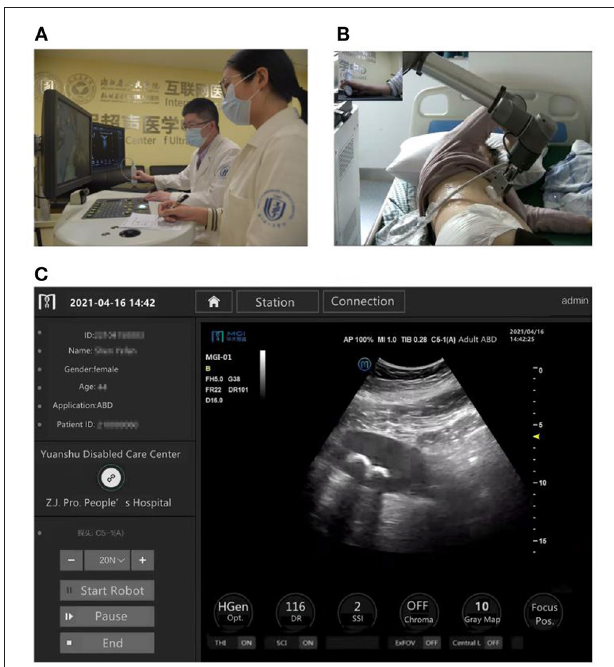
FIGURE 2 | The 5G-based robot-assisted remote ultrasound used for patients in a rural care center for persons with disabilities in China. (A) The doctor-side operational scenario in Hangzhou. (B) The patient-side operational scenario in Deqing, 35.9 kilometers away from Hangzhou. (C) Ultrasound images captured from the patient-side subsystem were sent to the doctor-side subsystem in real time.